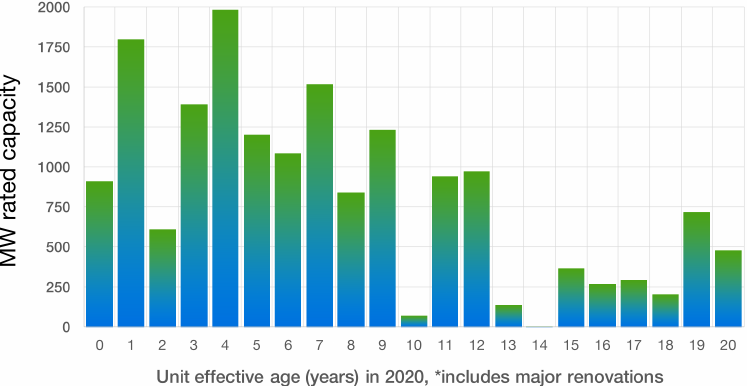
Figure 3. Capacity age-distribution of retrofit-applicable coal units (in the year 2020).